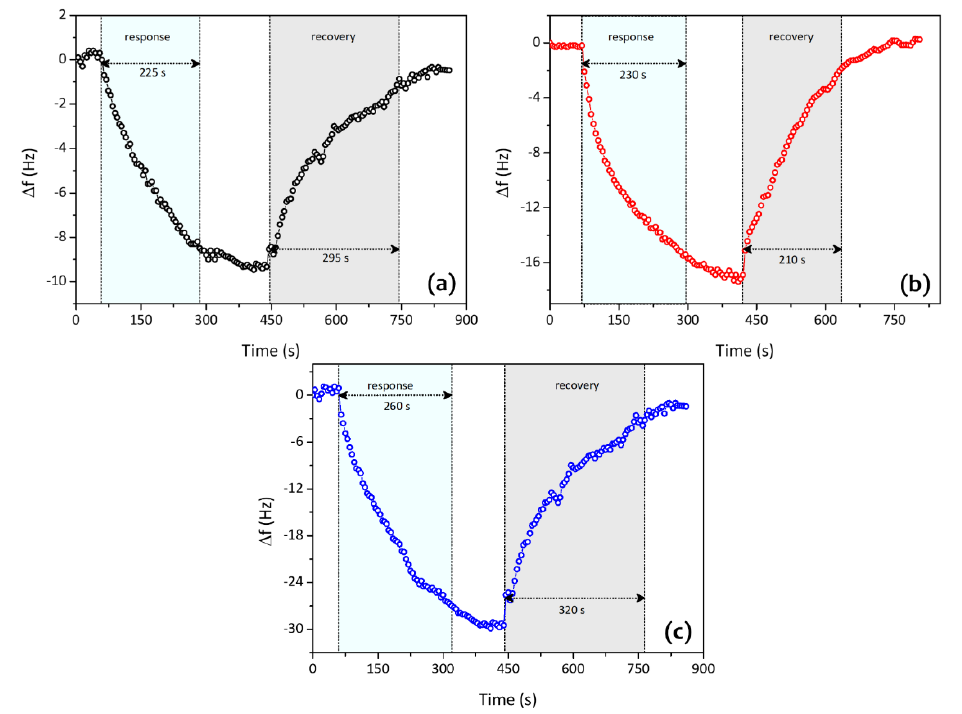
Figure 6. Response and recovery investigation of the PVAc based film of QCM sensor after being exposed to 622 ppm of ( a ) benzene, ( b ) toluene, and ( c ) xylene vapors.